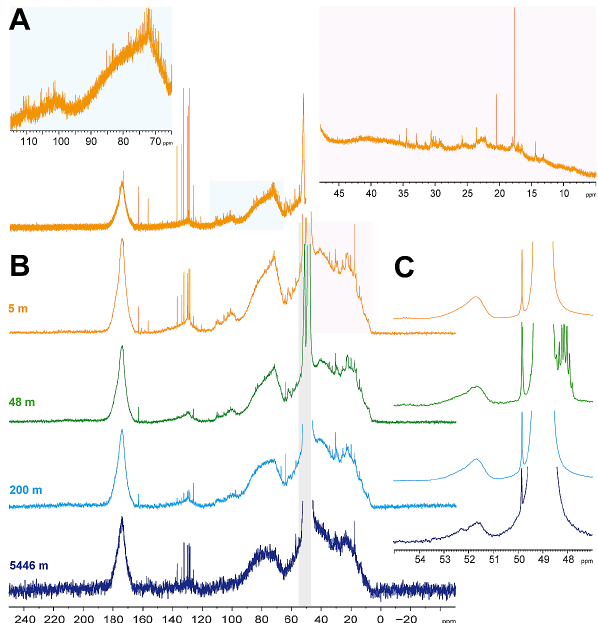
Fig. 3. 13 CNMR spectra of marine SPE-DOM ( 12 CD 3 OD solu- tion) obtained by solid phase extraction (PPL) at different depths indicated by color: 5m (near-surface photic zone), 48m (fluores- cence maximum), 200m (upper mesopelagic zone), and 5446m (30m above seafloor). (A) Apodization, exponential multiplication with LB=1Hz, showing resolved NMR resonances from abun- dant molecules; (B) apodization, exponential multiplication with LB=12.5Hz, fair compromise between decent resolution and S/N ratio; (C) apodization, exponential multiplication with LB=5Hz (methoxy NMR